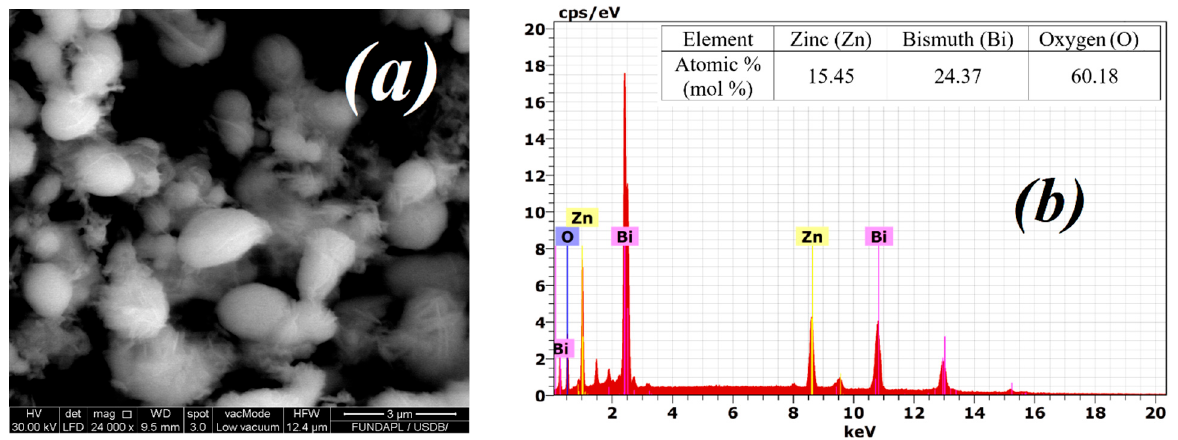
Figure 3. ( a ) SEM ( b ) Energy dispersive X-ray spectrum of ZnBi 2 O 4 .